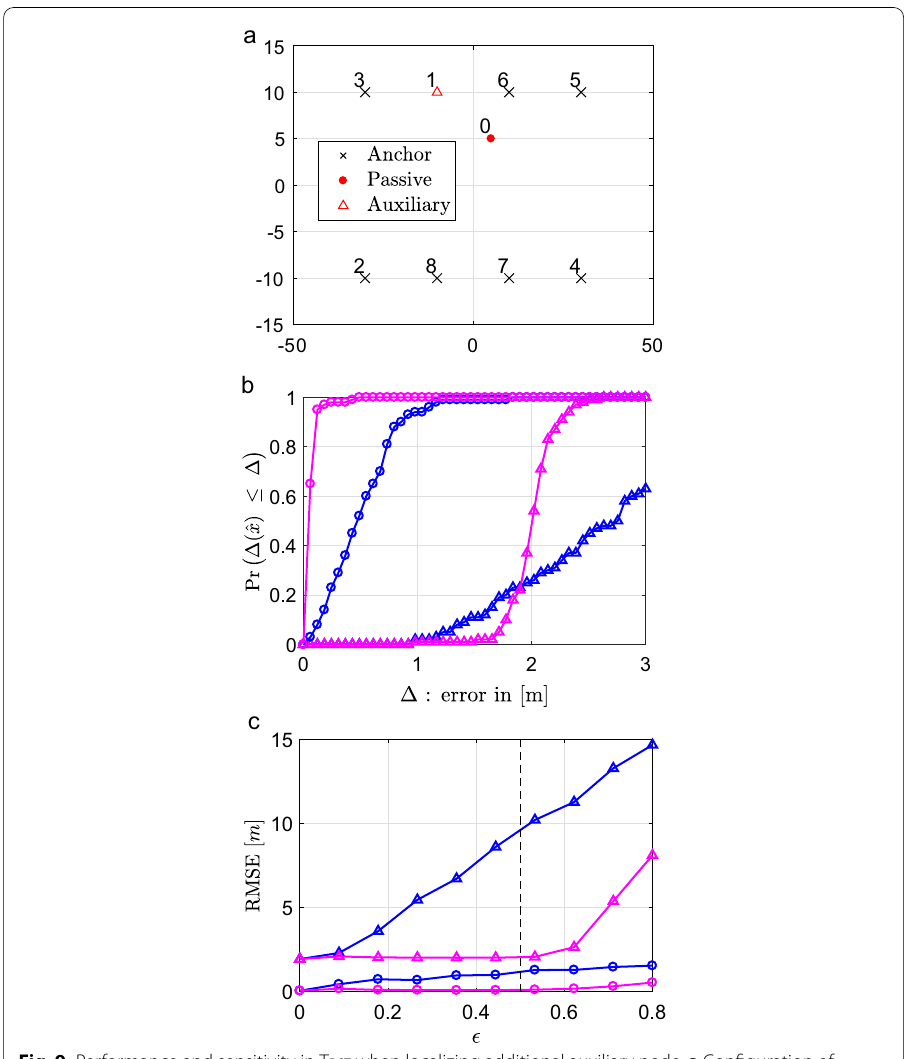
Fig. 9 Performance and sensitivity in T dsT when localizing additional auxiliary node. a Configuration of x ) using 100 Monte Carlo runs for auxiliary (triangle) and wireless network. b cdf of localization errors �( passive node (circle), using the standard (blue) and robust (magenta) methods, respectively. Unknown ǫ = 20% . c Root mean square error as a function of the fraction of corruption fraction is ǫ = 15% and (cid:31) corrupted data ǫ using standard (blue) and robust (magenta) method, for passive (circles) and auxiliary ǫ = 50% indicated by the (triangles) nodes, respectively. Results based on 50 Monte Carlo simulations. (cid:31) black-dashed (cid:31)